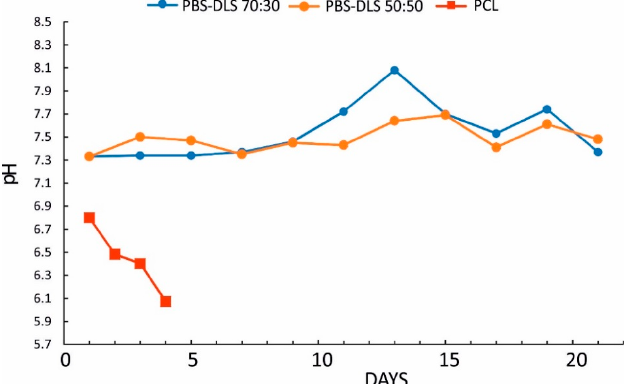
Figure 4. Changes in the pH of degradation media during degradation for PBS-DLS 70:30, PBS DLS 50:50, and PCL films.